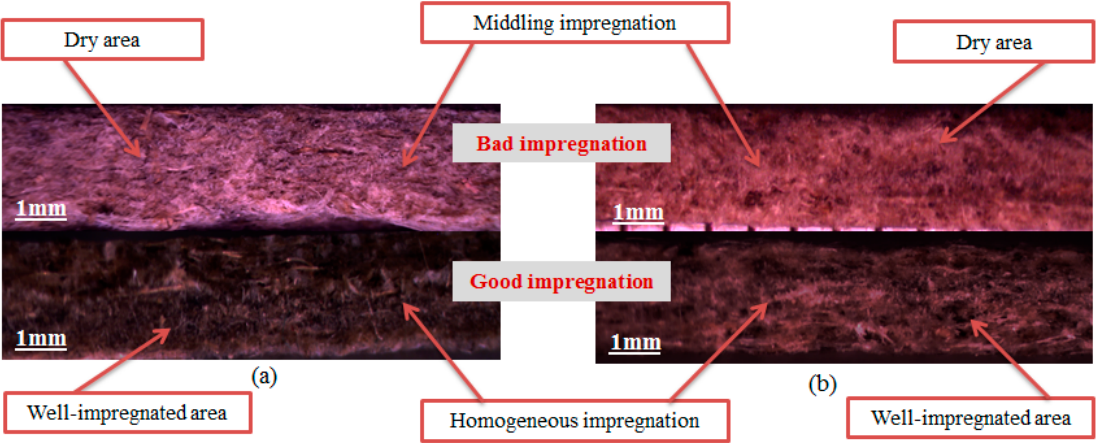
Figure 1. Microscopic observation on the cross-section, ( a ) A2000 nonwoven reinforced composite, and ( b ) B150 nonwoven reinforced composite. Table 2. The main parameters of the tested nonwoven composites.